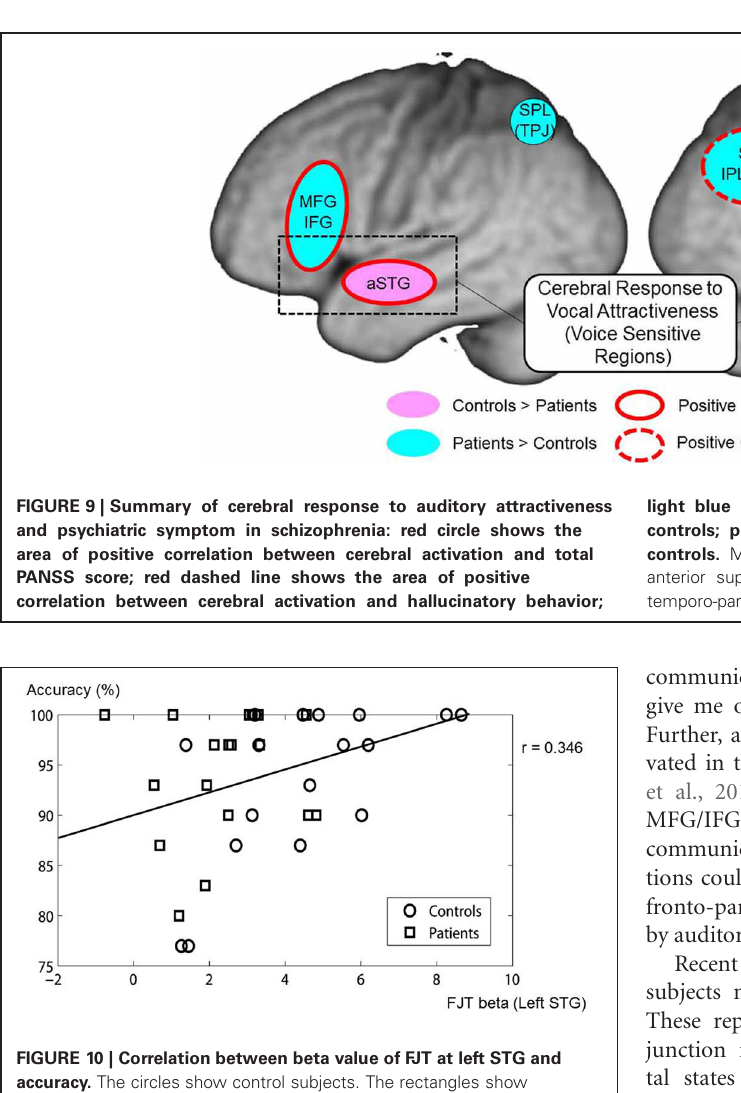
FIGURE 10 | Correlation between beta value of FJT at left STG and accuracy. The circles show control subjects. The rectangles show schizophrenia